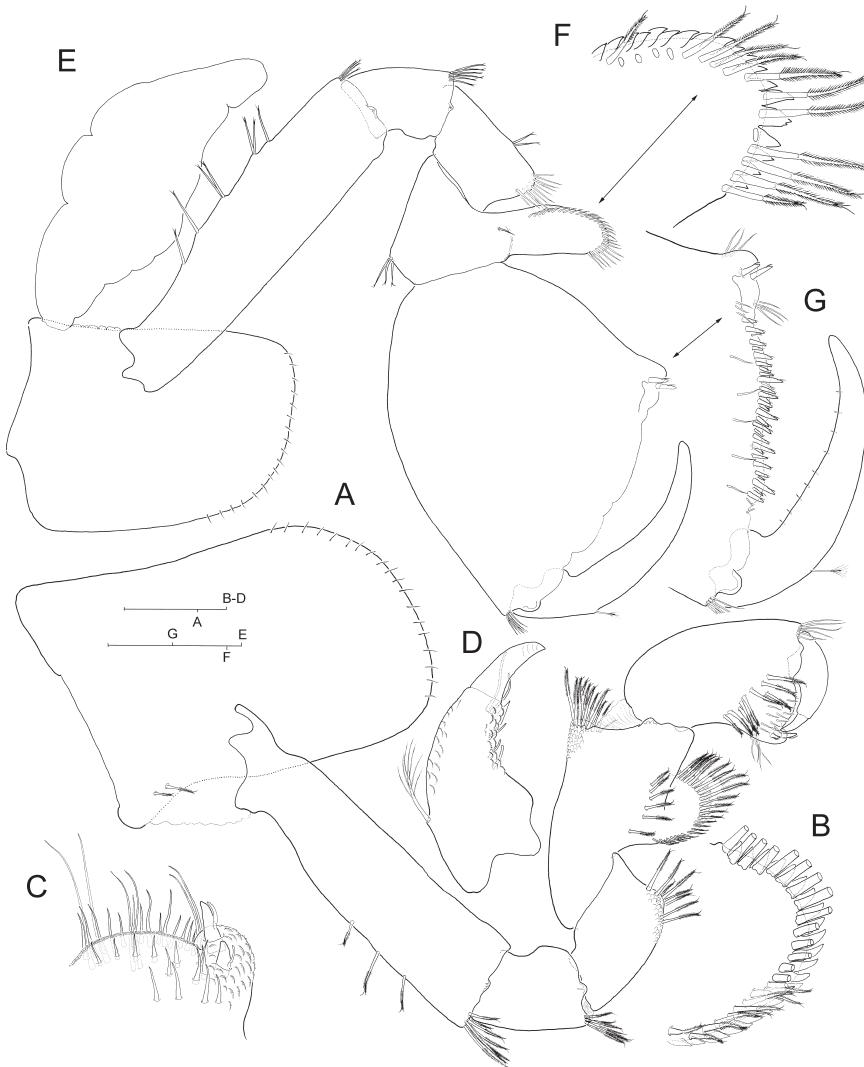
Figure 3. Hyalella cajasi sp. n., male. A left gnathopod 1, medial (armature on palm margin of propo- dus and on dactylus omitted) B inset of carpal lobe, medial C inset of palm margin and palm angle of propodus, medial D inset of dactylus, medial E right gnathopod 2, medial (armature on palm margin of propodus and on dactlylus omitted) F inset of carpal lobe, medial G detail of palm margin and palm angle of propodus, and of dactylus, medial (submarginal armature along lateral side of palm margin omitted). Scale bars: 0.2 mm ( A, G ); 0.1 mm ( B–D, F ); 0.5 mm ( E